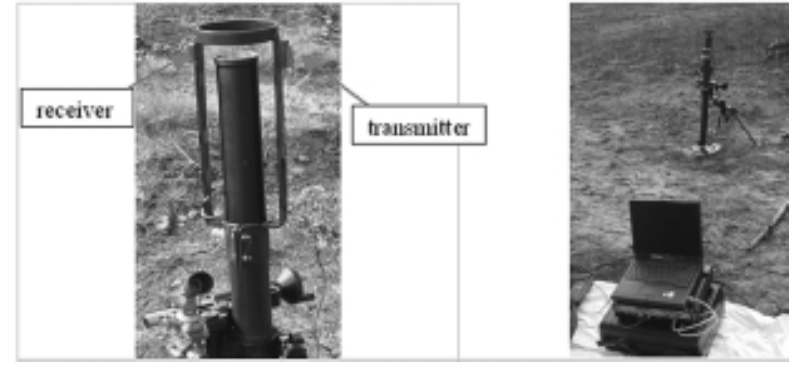
Fig. 5. Experimental set-up for measurement of initial